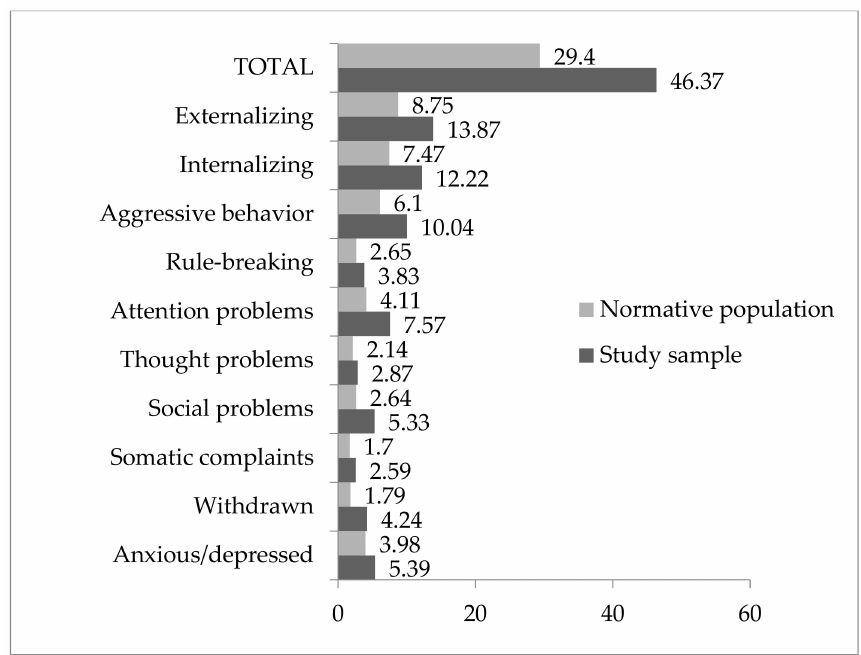
Figure 1. Di ff erence of means with a normative population (direct scores).